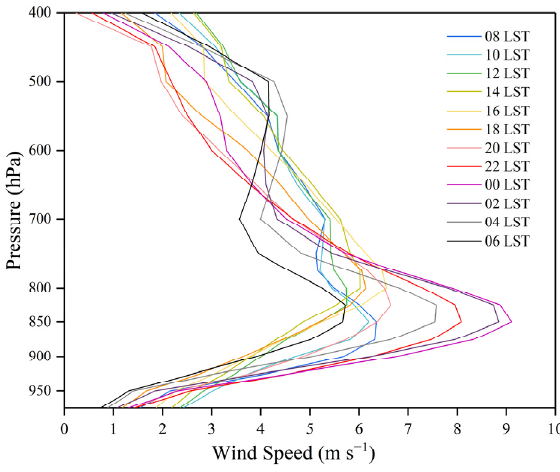
Figure 7. Diurnal variations of wind speed profiles in region S.